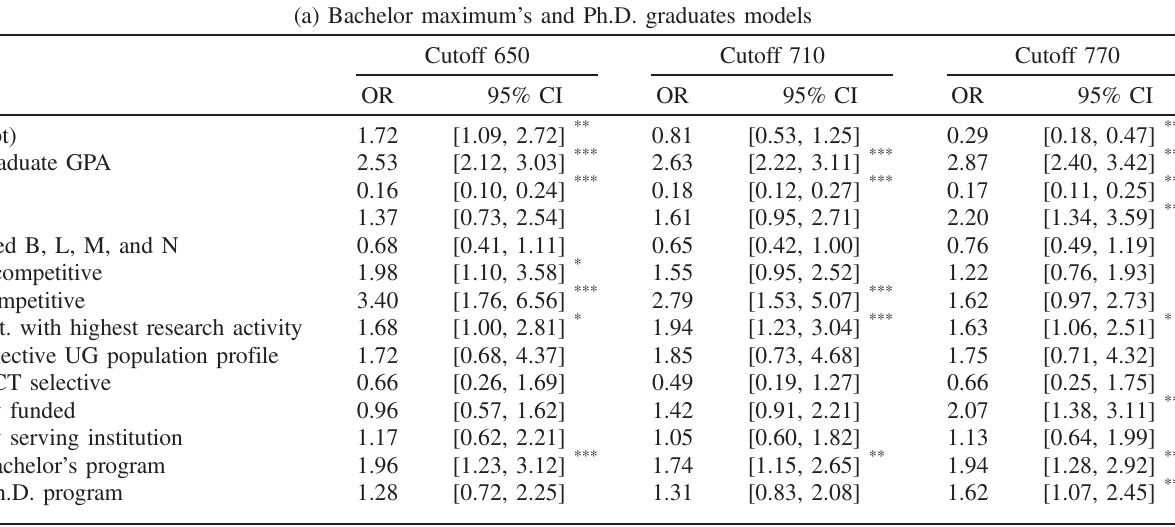
TABLE IV. Odds ratios for P-GRE cutoff scores 650, 710, and 770 of the logistic regression models with possible duplicates (see Sec. III C). The maximum and minimum graduates models are separated in tables (a) and (b), respectively. Statistically significant odds ratios are marked with asterisks [see below (b)]. Note that ˜ p ¼ 14 p refers to the Bonferroni-corrected p values. (a) Bachelor maximum ’ s and Ph.D. graduates